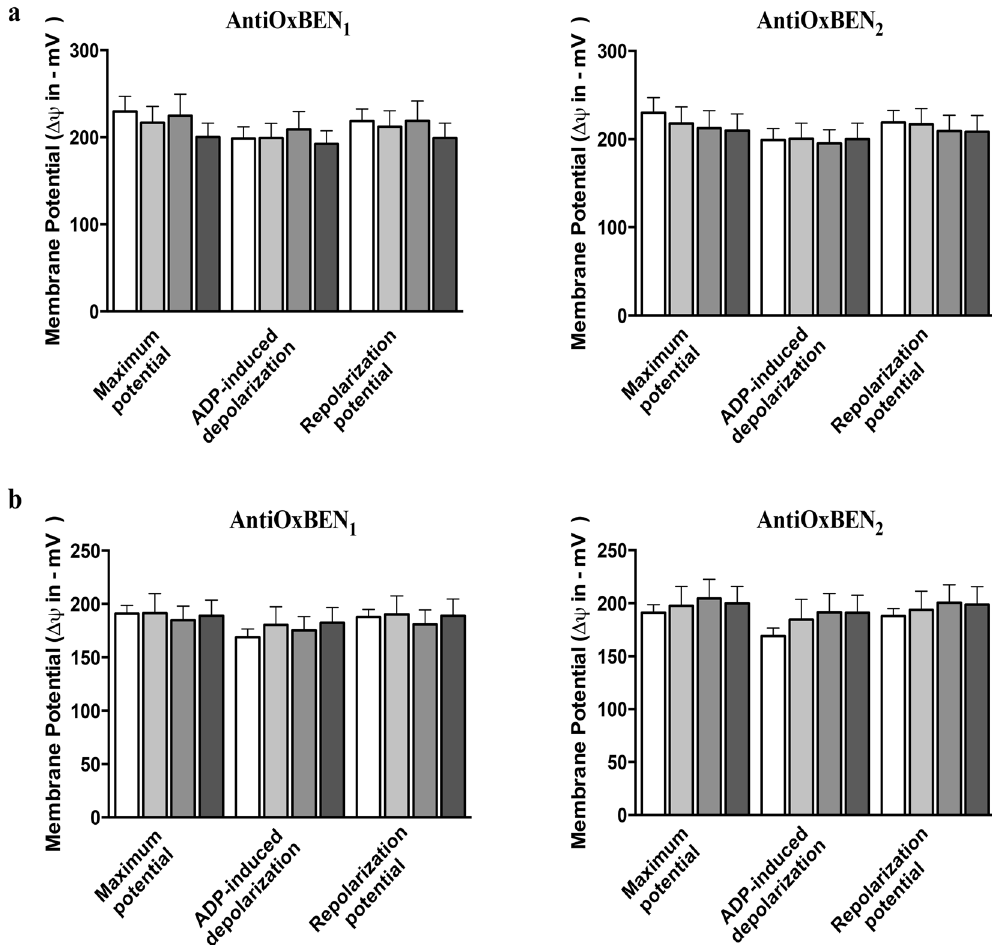
Figure 5. Effects of AntiOxBENs on RLM transmembrane electric potential ( ΔΨ ) supported by ( a ) 10 mM glutamate + 5 mM malate or ( b ) 5 mM succinate. The white bars refer to the control, while grey bars refer to the experiments where RLM were pre-incubated with AntiOxBENs (2.5 μ M – light grey; 5 μ M – grey; and 10 μ M – dark grey). The presented results are means ± SEM of five independent experiments. The statistical significance relative to the different bioenergetics parameters was determined using Student’s two tailed t-test ( * P < 0.05, ** P < 0.01, *** P < 0.0005, **** P <